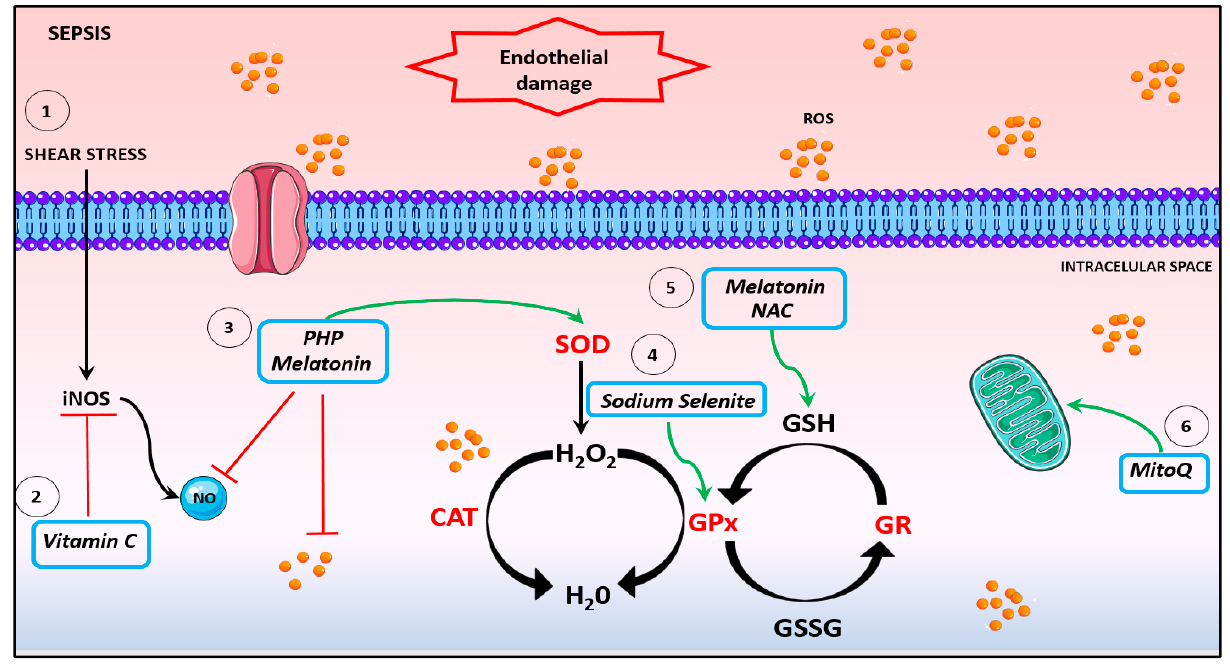
Figure 2. Potential antioxidants therapies. (1) The inflammatory scenario of sepsis induces shear stress, causing endothelium damage and activation of iNOS, leading to an NO boosting. (2) Vitamin C is an antioxidant acting on iNOS inhibition expression, improving microvascular dysfunction and ameliorating hypotension. (3) The compound PHP and melatonin sequestrate NO and promote SOD activation. (4) Sodium selenite promotes an increase in GPx activity. (5). NAC and melatonin restore GSH levels and inhibit platelet and neutrophil dysfunction. (6). MitoQ enhances mitochondrial respiration and restores mitochondrial dysfunction. NO: nitric oxide. CAT: catalase. SOD: superoxide dismutase. GPx: glutathione peroxidase. GR: glutathione reductase.